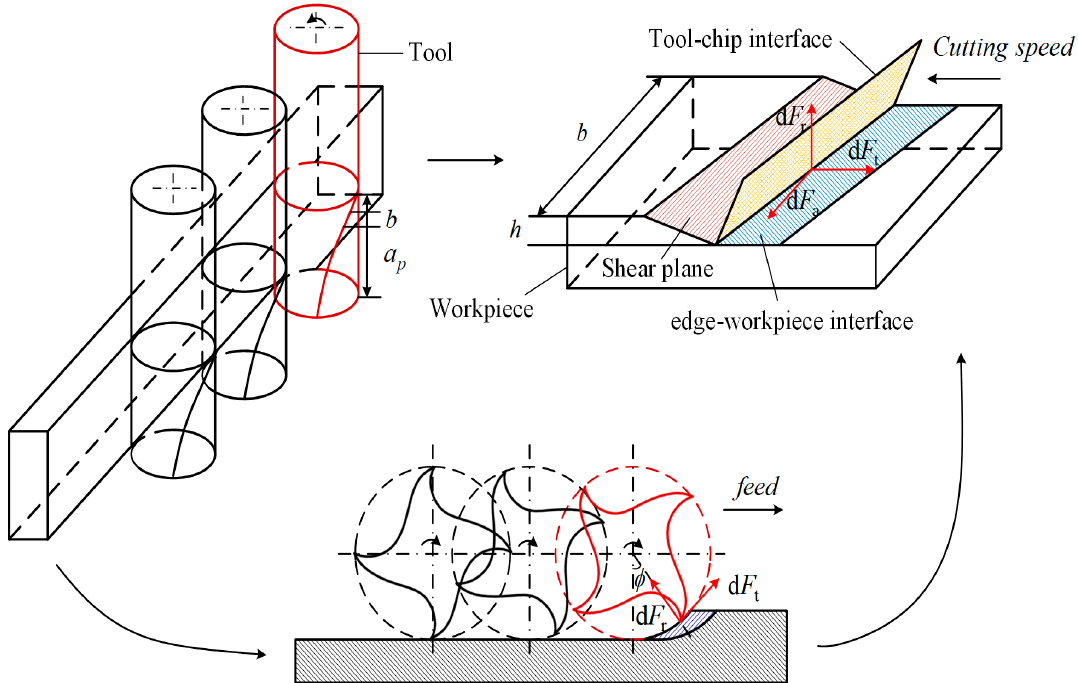
Figure 2. Interaction of tool and workpiece in milling process.